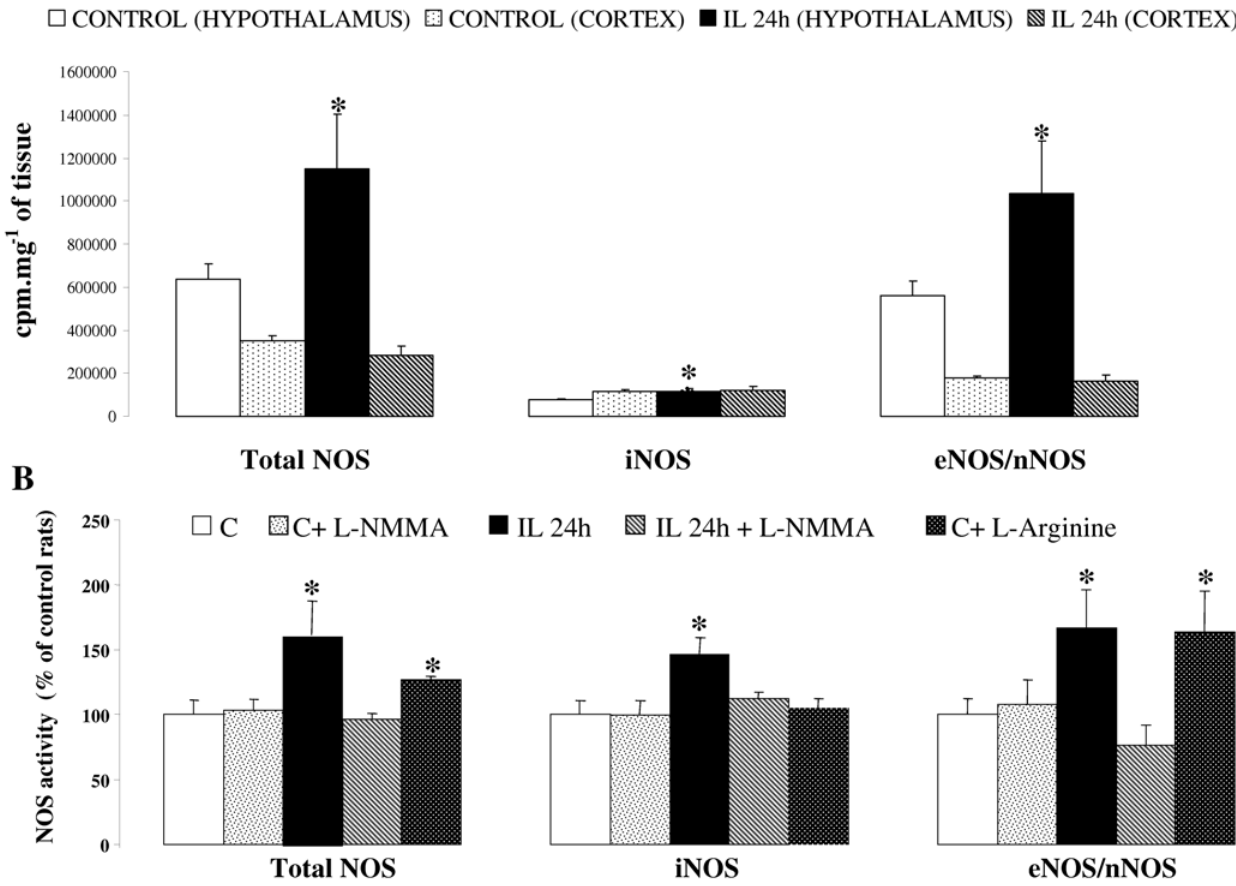
Figure 2. Effect of lipid infusion on central NOS activities. A: Hypothalamic and cortical NOS activities after 24 h of Intralipid/heparin infusion (IL 24 h) or saline/heparin infusion control group (C). Results are expressed as c.p.m per mg of tissue. B: Hypothalamic NOS activities of IL and C rats treated or not with acute injection of non selective NOS inhibitor, L-NMMA. The last right bar displays NOS activities in C rats injected with NOS substrate, L-Arginine. Results are expressed as percentage of C group activities. * p , 0.05 vs.